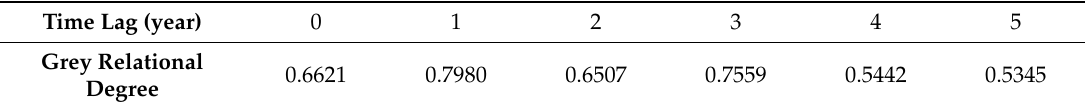
Table 2. Grey relational degrees between the spring flow and precipitation under di ff erent time